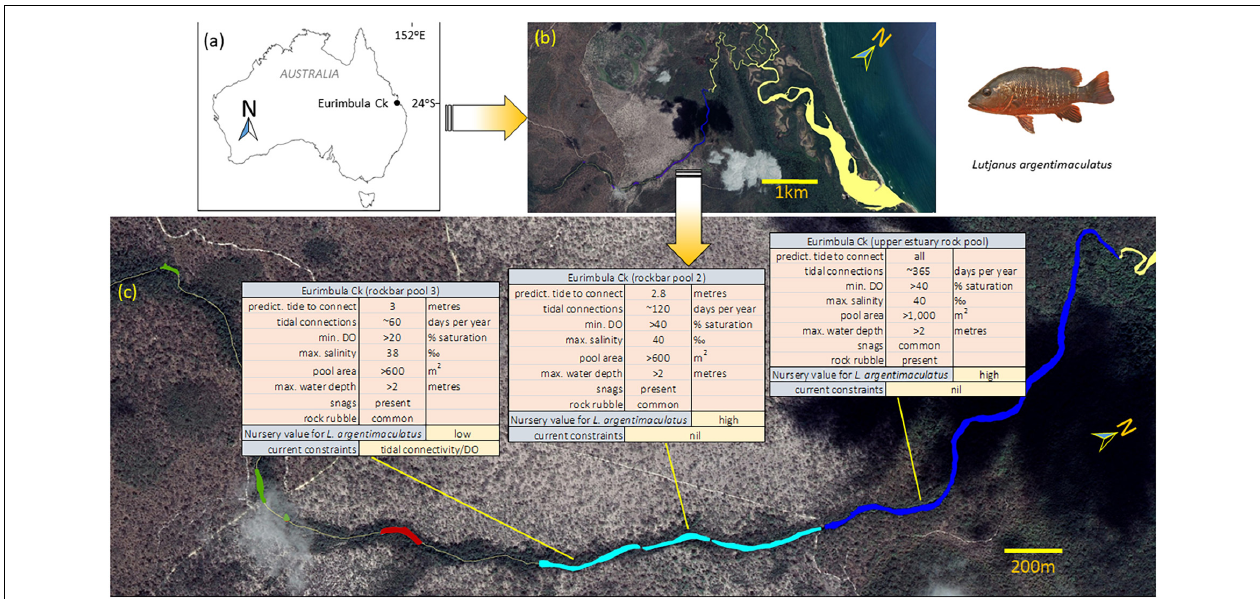
FIGURE 4 | Example of a Constraint Map from a study by (See Footnote 1) aimed at improving the understanding of the factors that determine nursery usage at a species level, for three coastal fisheries species, in the case of this example the snapper Lutjananus argentimaculatus. Panels (a) and (b) location maps; (c) constraint tables for key constraints for nursery utilisation of three upper estuarine pools in Eurimbula Creek for L. argentimaculatus. The colour in the map indicate the level of tidal connectivity and salinity (dark blue = connected at every high tide, with marine to hypersaline conditions; light blue = connected during most high tide with marine to hypersaline conditions; Red = only connected on the highest spring tides with fresh to hyposaline conditions; Green = never tidally connected fully